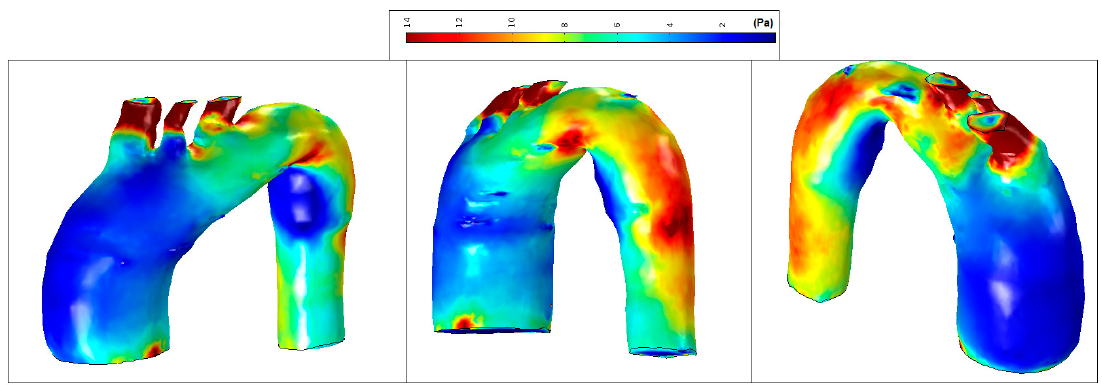
Figure 16. Patient 2: wall shear stress (WSS) contours (at peak systole).